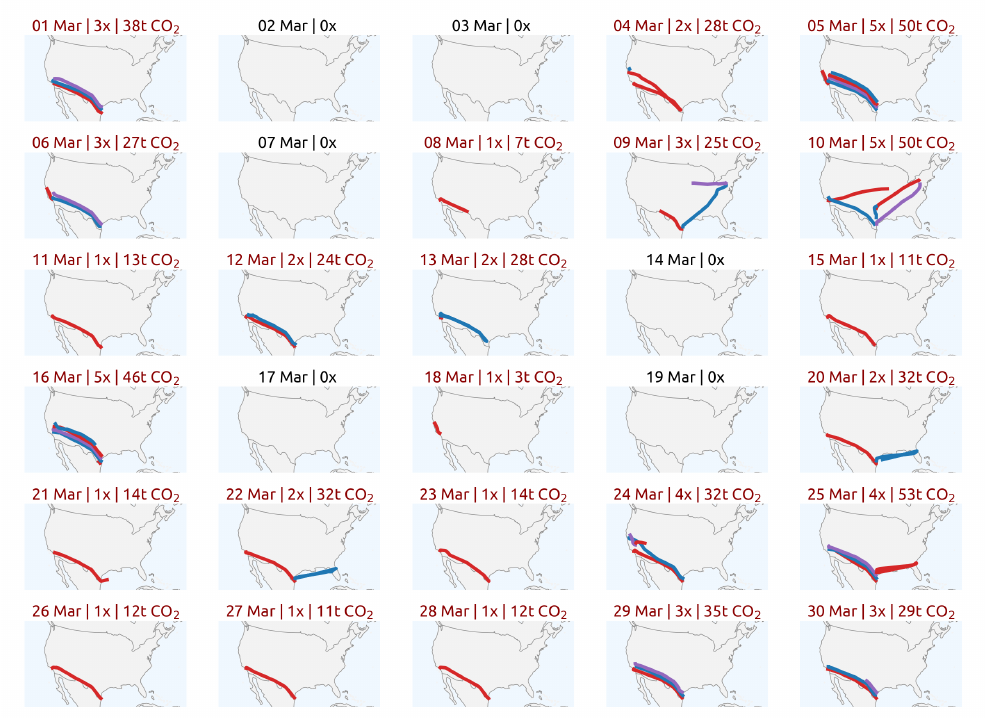
Figure 10. A total of 50 trips were carried out by Elon Musk’s private jet during March 2020. The trips produced more than 600 tonnes of CO 2